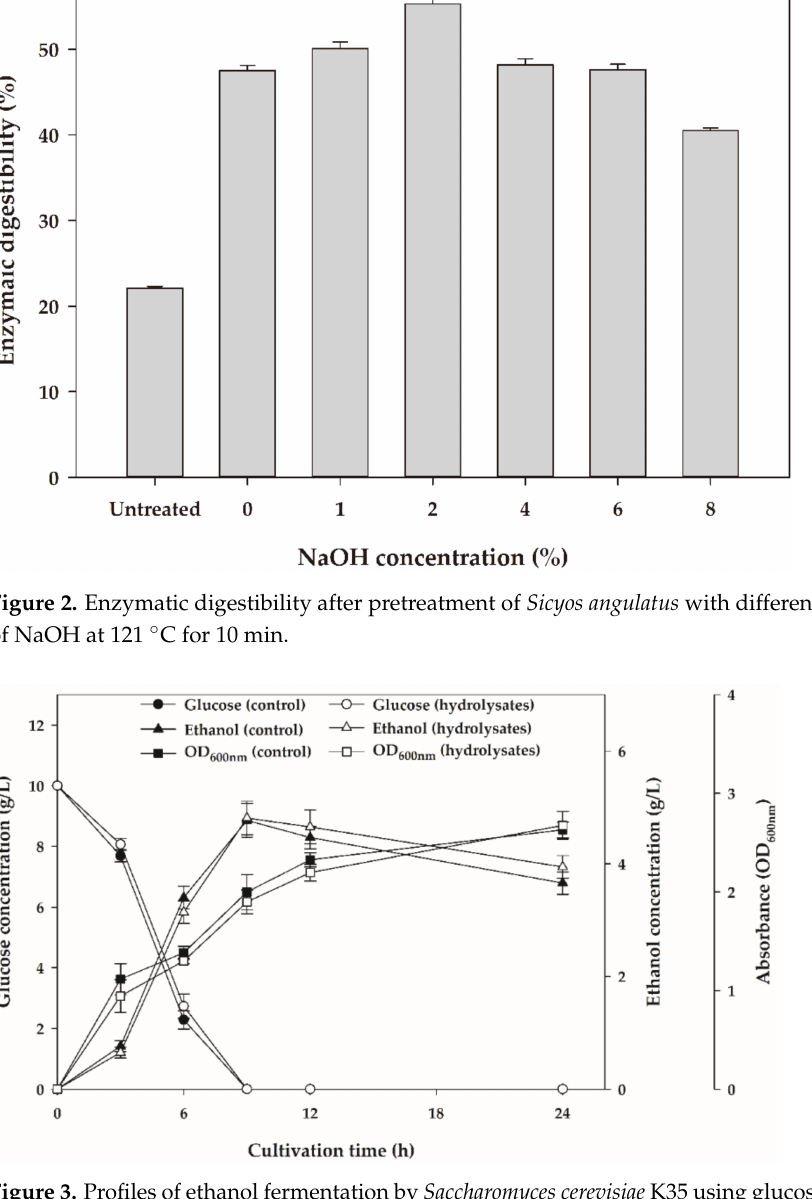
Figure 3. Profiles of ethanol fermentation by Saccharomyces cerevisiae K35 using glucose (filled symbol) and hydrolysates (hollow symbol) of Sicyos angulatus pretreated with 2% NaOH at 121 ◦ C for 10 min as carbon